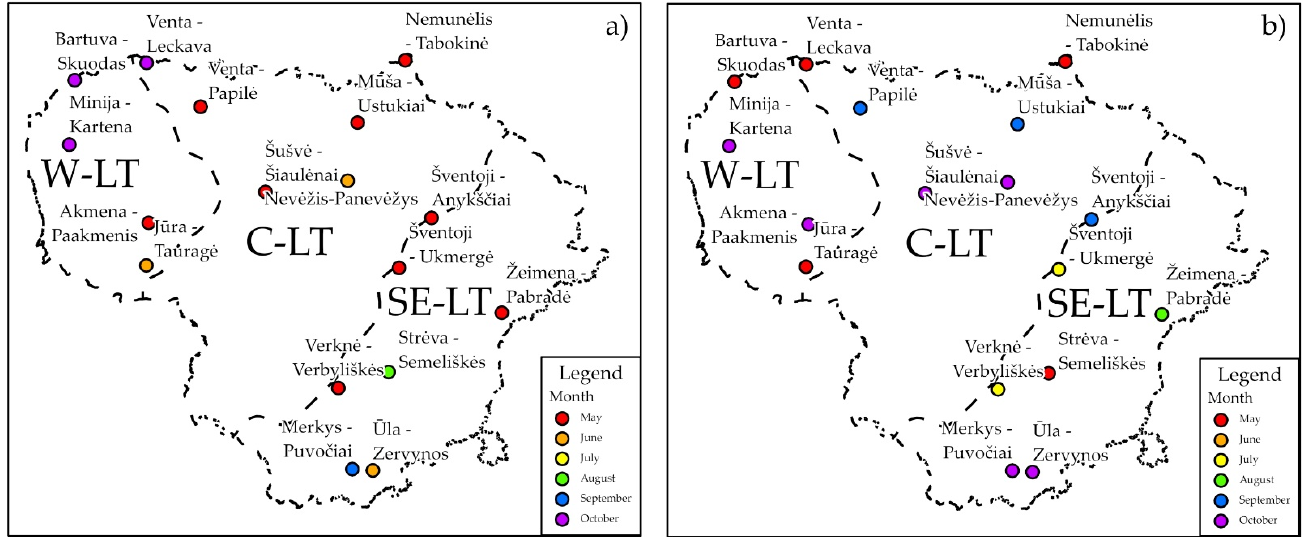
Figure 8. Distribution of rivers according to the driest months in the warm period: ( a ) SDI index with 1-month accumulation period; ( b ) SDI index with 12-month accumulation period.